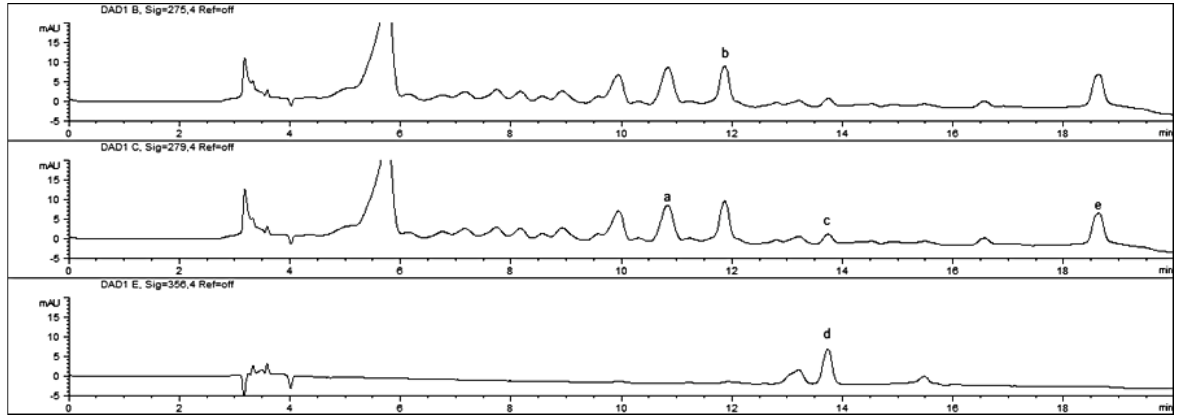
Figure 3. HPLC chromatograms of 50% (v/v) aqueous methanol extract obtained from fig seeds ( a chlorogenic acid, b (-)-epicatechin, c syringic acid, d rutin and e